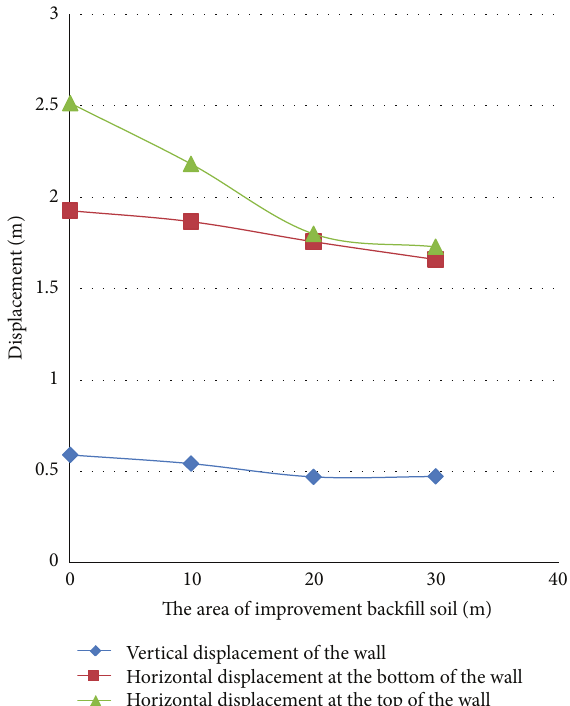
Figure 10: Horizontal and vertical displacements of the quay wall in different soil improvement areas behind the wall.